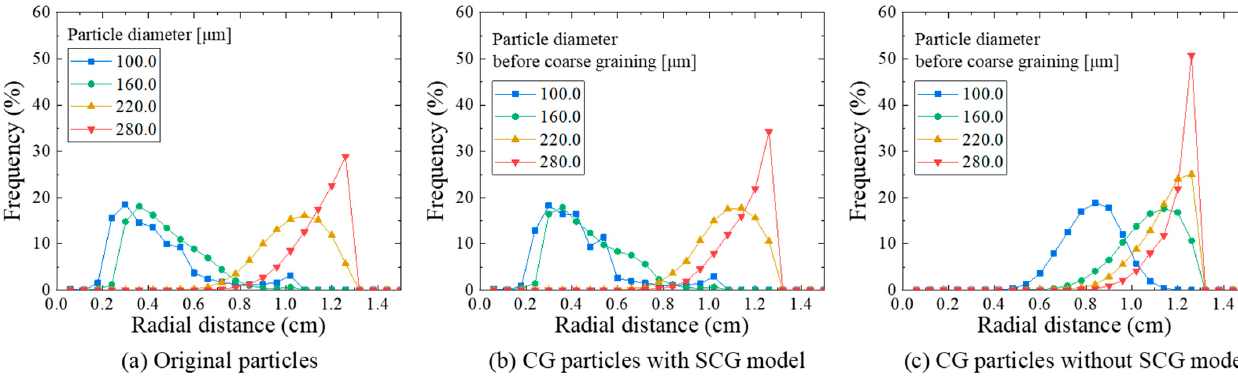
Figure 9. Snapshot of particle behaviors in the classifier after 0.25 s passed.